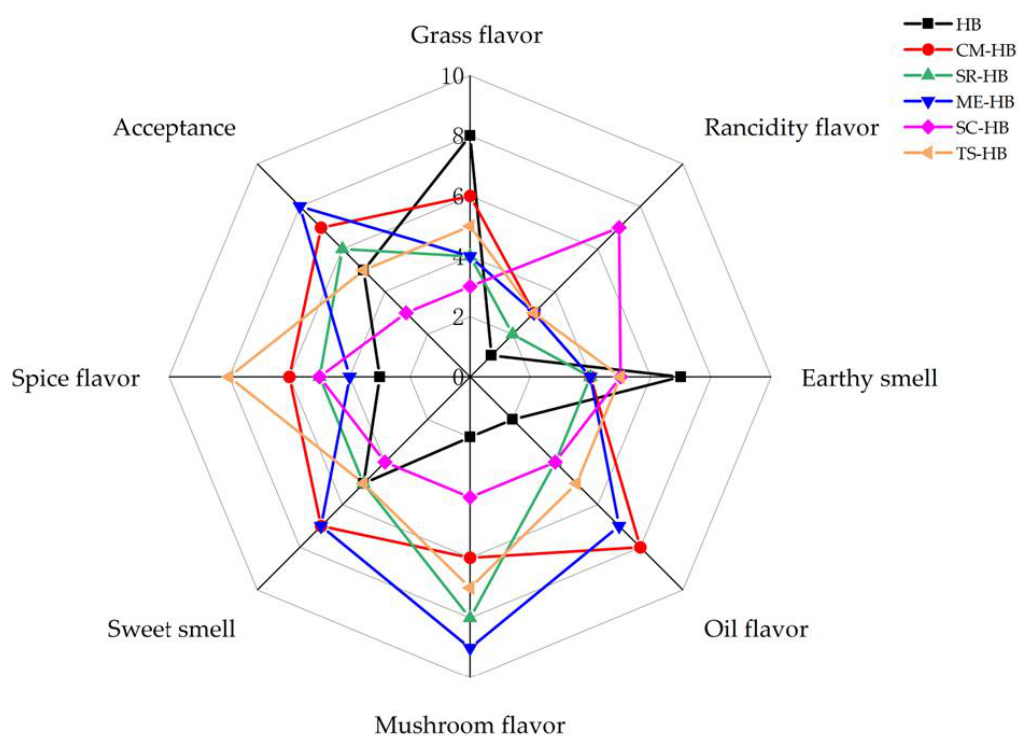
Figure 5. Flavor characteristics of original and fermented highland barley samples: HB (original highland barley), CM-HB (fermented highland barley with C. militaris ), SR-HB (fermented highland barley with S. rugoso-annulata ), ME-HB (fermented highland barley with M. esculenta ), SC-HB (fer- mented highland barley with S. commune ), TS-HB (fermented highland barley with T. sanguinea ). 0 to 10 indicated the intensity of the different descriptors rated by each panelist in this study